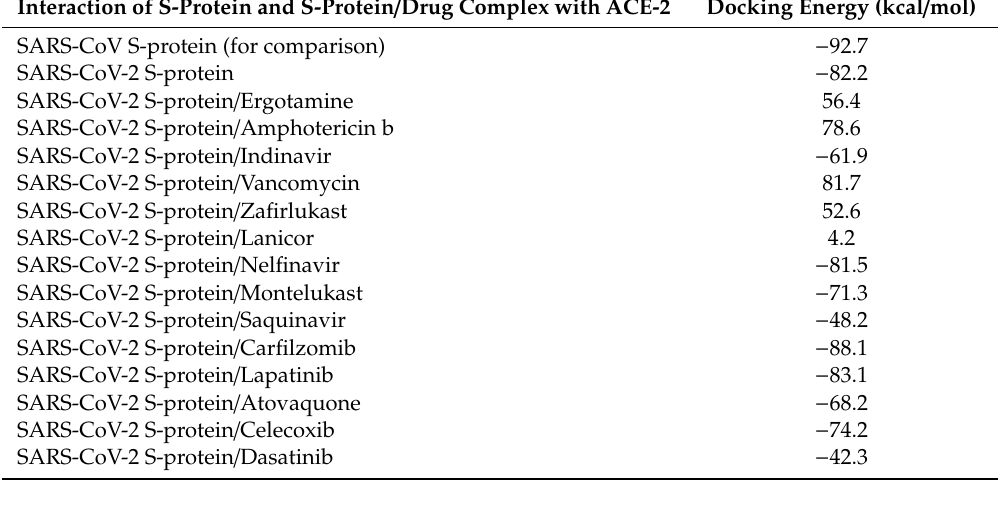
Table 3. Docking energy of the SARS-CoV S-protein with and without ligands to human ACE-2. Interaction of S-Protein and S-Protein / Drug Complex with ACE-2